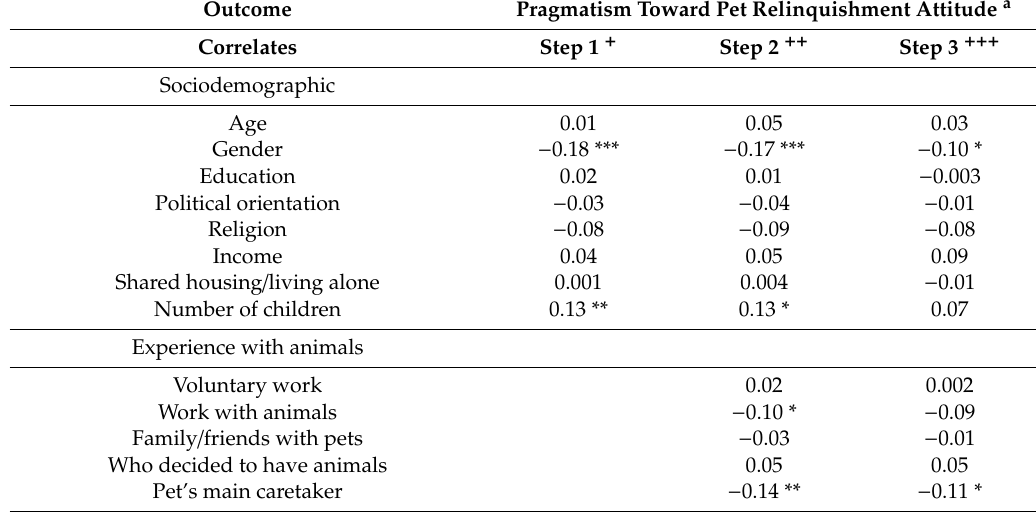
Table 3. Correlates of pragmatism toward pet relinquishment attitude (standardized regression coe ffi cients and associated